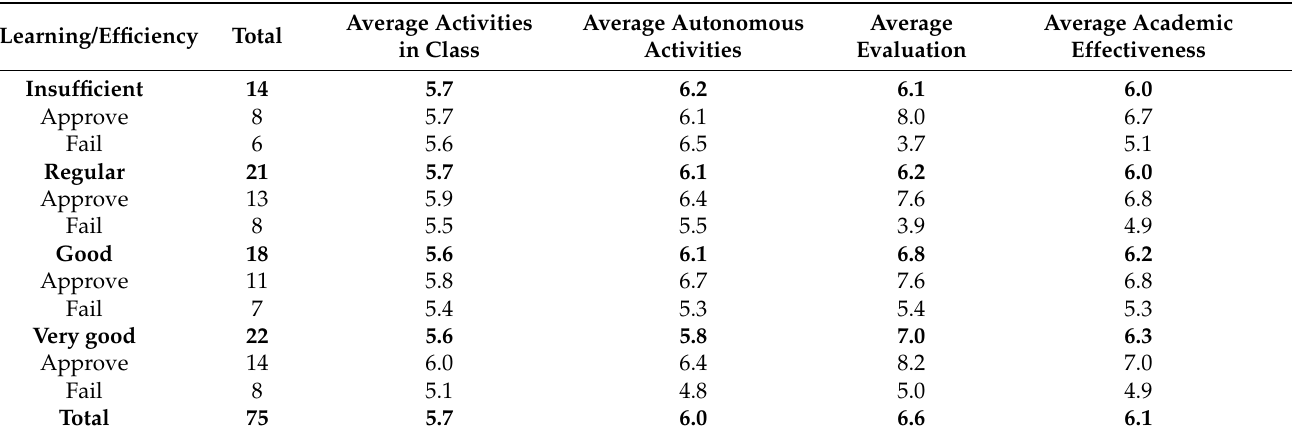
Table 14. Analysis of the data obtained from the 2019 period with the establishment of the categories of learning and academic